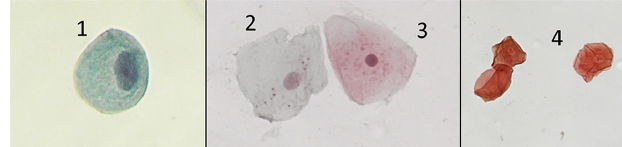
Fig.1. Cellular types of normal oral mucosa epithelium: 1) parabasal; 2) intermediate; 3) superficial with nuclei and 4) anucleated. (Papanicolaou method,